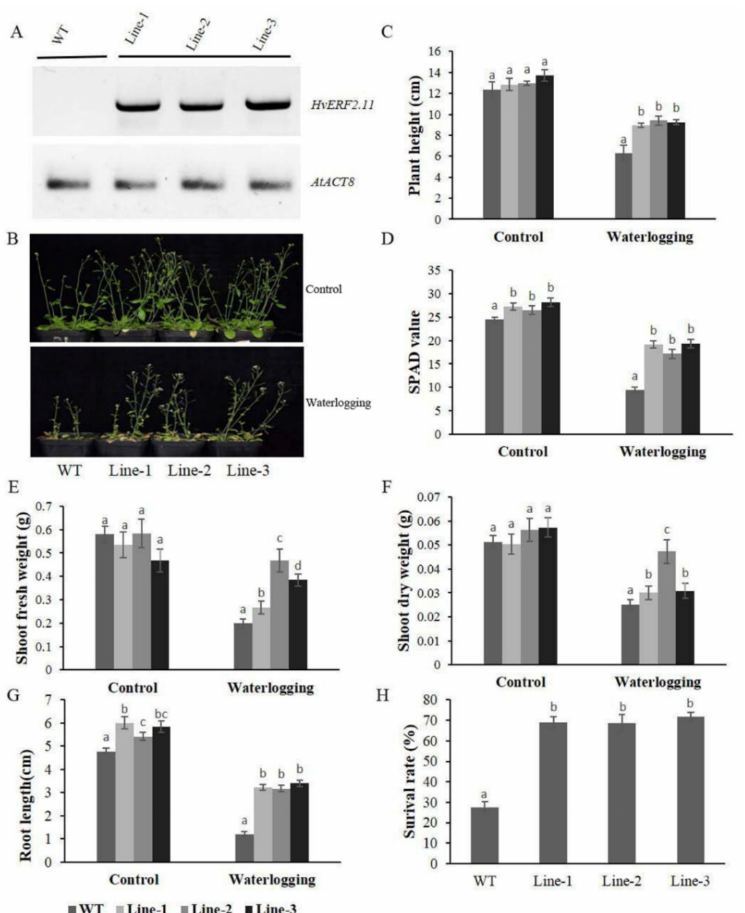
Figure 5. Waterlogging tolerance assay of HvERF2.11 overexpression lines (Line1, Line2, Line 3) and wild-type (WT). ( A ) RT-PCR analysis of transgenic and wild-type plants. AtACT8 was chosen as control gene. ( B ) Five week-old plants were subjected to waterlogging stress for further 2 weeks. ( C ) Plant height. ( D ) Soil-plant analysis development (SPAD) value (based on chlorophyll meter reading). ( E ) Shoot fresh weight. ( F ) Shoot dry weight. ( G ) Root length. ( H ) Surival rate in the wild-type and HvERF2.11 transgenic lines were measured under control and waterlogging stress. Values are the means ± SD. Means were generated from three independent measurements. Data were analyzed by one-way analysis of variance followed by Duncan’s test. Different letters represent statistically significant differences ( p <